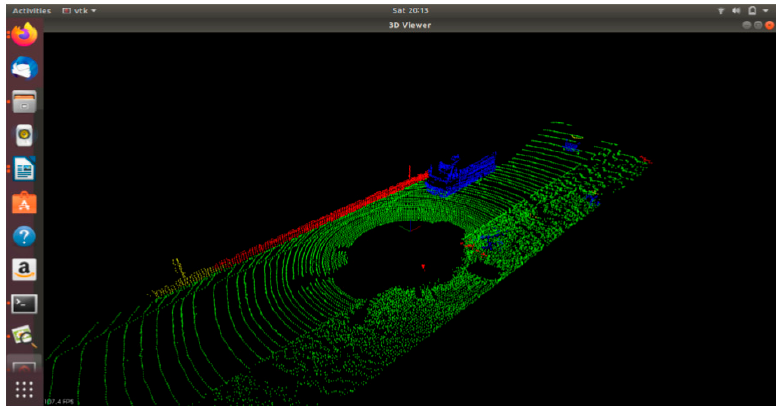
Figure 6. LiDAR point cloud: the points other than green represent high-density clusters.